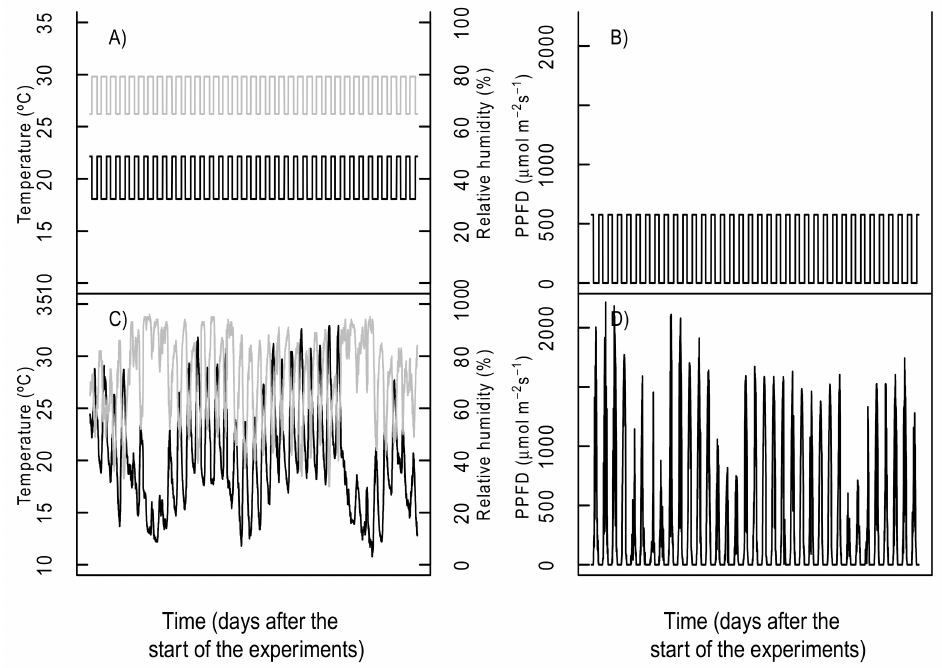
Figure 1. Applied temperature and light conditions for the phytotron treatments. The upper panels correspond to the applied fixed temperature/humidity (( A ) temperature = black line, relative air humidity = grey line) and photosynthetic active photon flux density ( B ). The lower panels correspond to the applied variable temperature/humidity (( C ) temperature = black line, relative air humidity = grey line) and light ( D ), corresponding to the climatic records during the 35 days of the natural field trial and applied under the variable